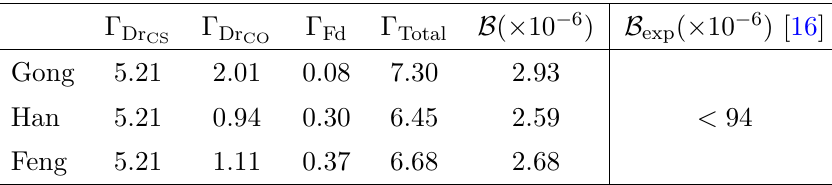
Table 1 . Decay widths of Z → Υ(3 S )+ X (in units of KeV). The subscripts “ Dr 00 and “ Fd 00 refer to the direct-production processes and feed-down effects, respectively. m b = 4 . 75 GeV and µ r = m Z / 2 .